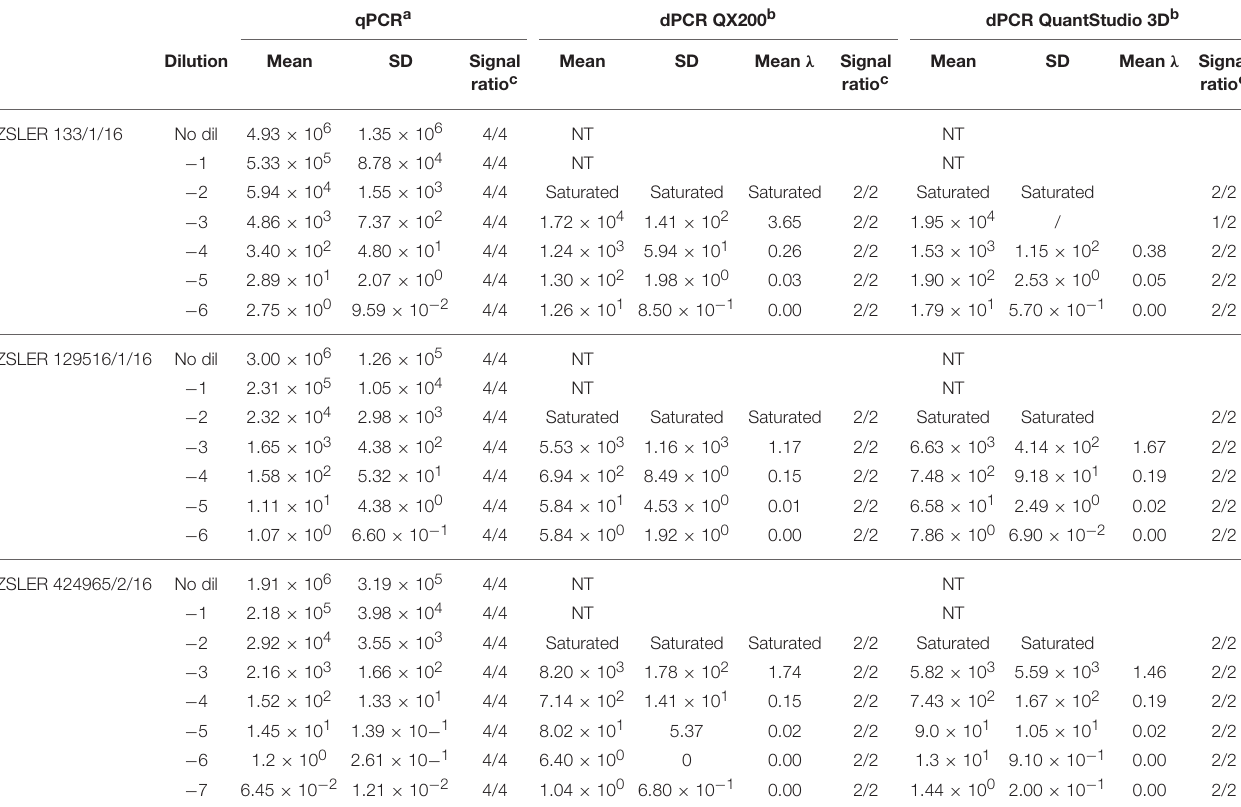
TABLE 3 | Experimental output of L. monocytogenes cells obtained by hlyA-qPCR, hlyA—QX200 dPCR and hlyA—QuantStudio 3D